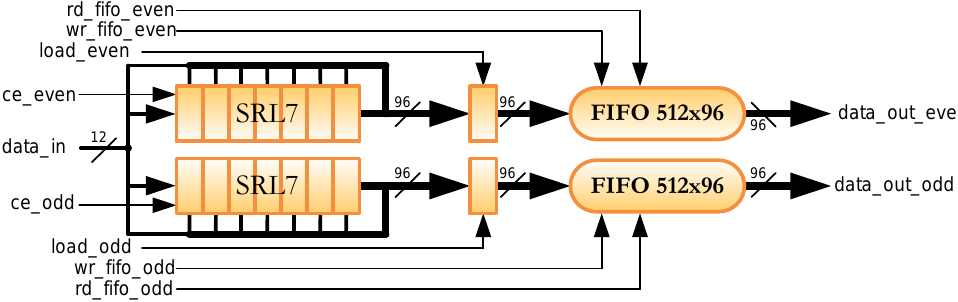
Figure 9. Block diagram of the implemented channel_swap.vhd module. Table 3. Port description of the swapping module.